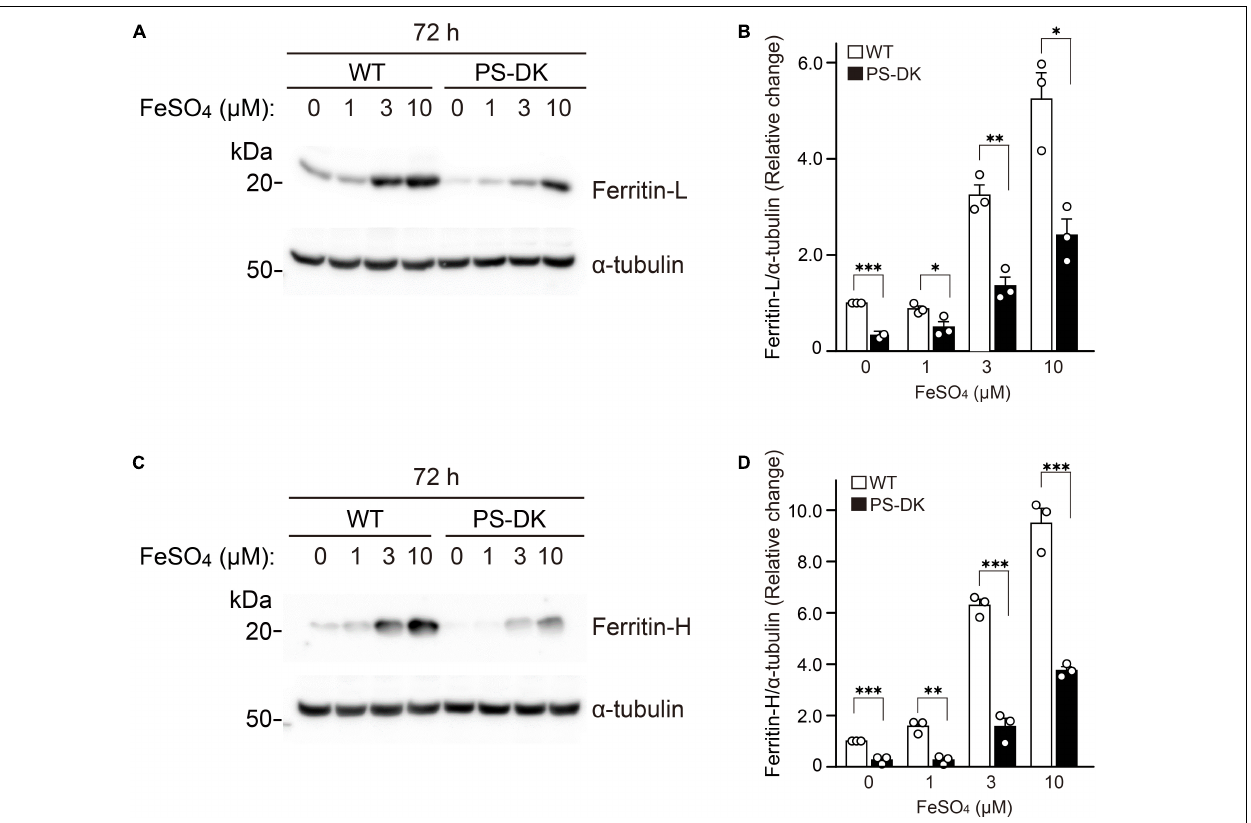
FIGURE 3 | PS deficiency reduced ferritin levels in response to iron treatment . (A) Western blot analysis of ferritin light chain in wild-type and PS-DK fibroblasts treated with ferrous sulfate. (B) Quantification of intracellular ferritin light chain levels. Their levels were normalized to α -tubulin protein levels. n = 3, from 3 independent experiments, ∗ P < 0.05, ∗∗ P < 0.01, ∗∗∗ P < 0.001, one-way ANOVA followed by Tukey’s multiple-comparison tests. (C) Western blot analysis of ferritin heavy chain in wild-type and PS-DK fibroblasts treated with ferrous sulfate. (D) Quantification of intracellular ferritin heavy chain levels. Their levels were normalized to α -tubulin protein levels. n = 3, from 3 independent experiments, ∗∗ P < 0.01, ∗∗∗ P < 0.001, one-way ANOVA followed by Tukey’s multiple-comparison tests. All quantitative data shown as mean ± SEM. Ferritin-L, ferritin light chain. Ferritin-H, ferritin heavy